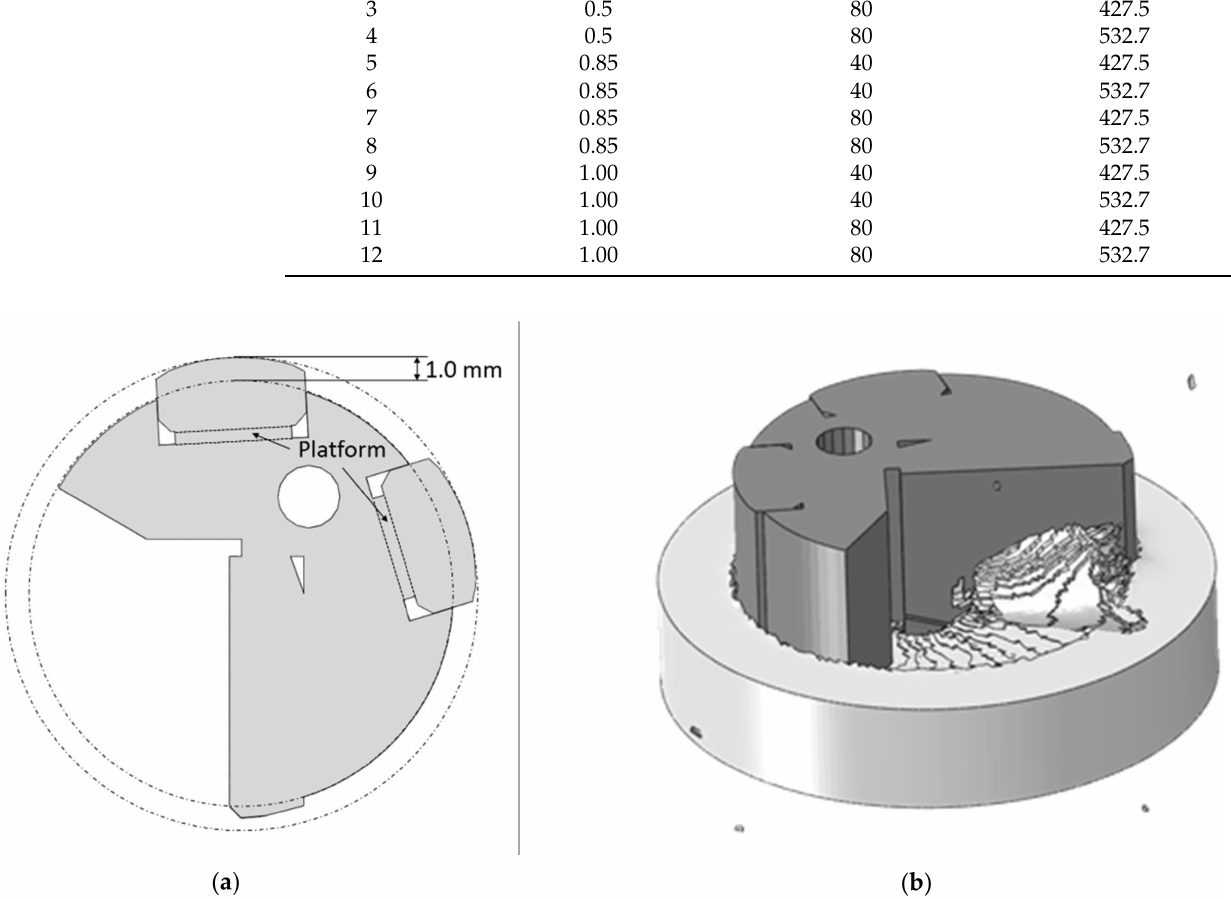
Figure 6. Definition of guide pad height ( a ) and chip formation after 0.055 s with a feed of 0.64 mm/rev (80 mm/s) and a cutting speed of 427.5 m/min ( b